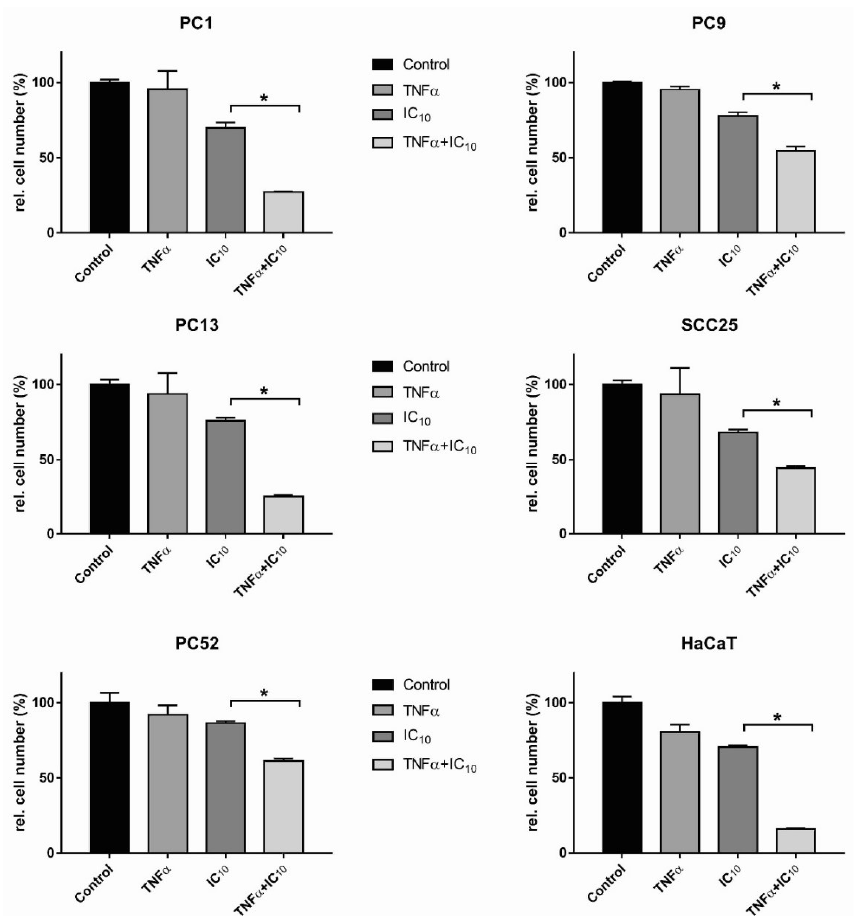
Figure 4. Relative cell number after stimulation with NF κ B inhibitor TPCA1 in combination with TNF α . To determine whether the combination of TNF α and TPCA1 leads to a reduction in cell number via cell death, all cell lines (1 × 10 4 /well) were stimulated with TNF α (100 ng/mL) and the cell line-specific IC 10 of TPCA1 for 72 h and stained with crystal violet. Data of one representative experiment